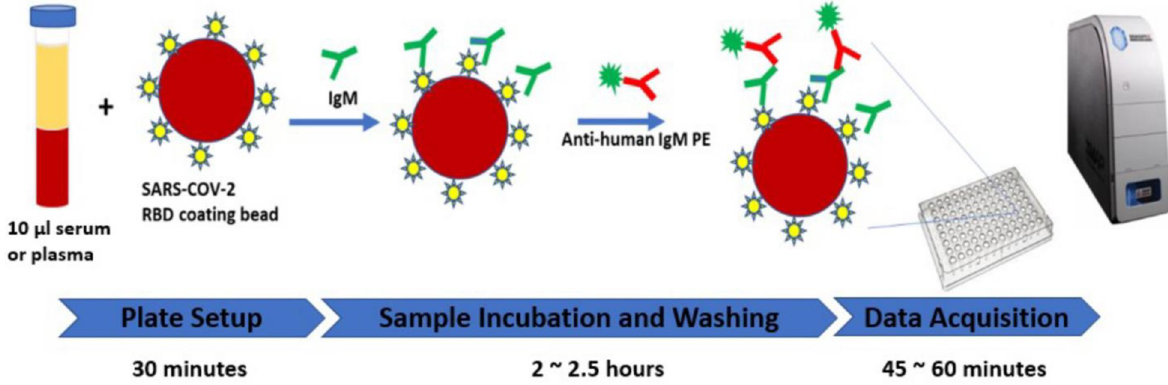
Fig 1. The high throughput immunoassay for anti-SARS-CoV-2 IgM detection.